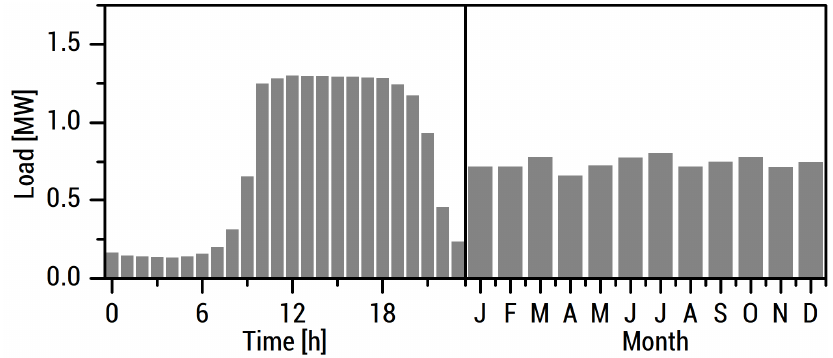
Figure A4. Hourly ( left ) and monthly ( right ) average load consumption in the commercial mall.